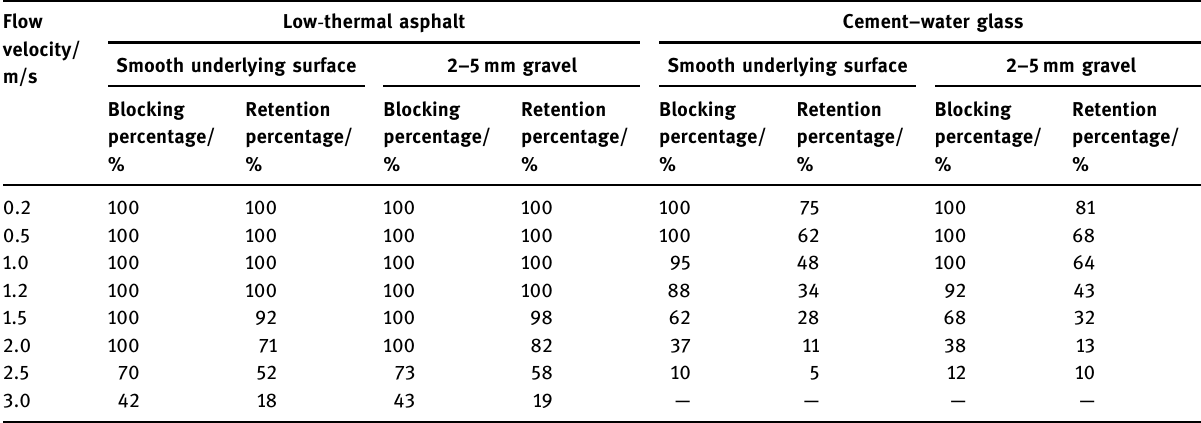
Table 5: Impact experimental results for typical materials